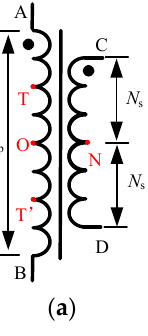
Figure 3. ( a ) Tap structure of the unconventional IPR; ( b ) Winding configuration of the unconventional IPR.